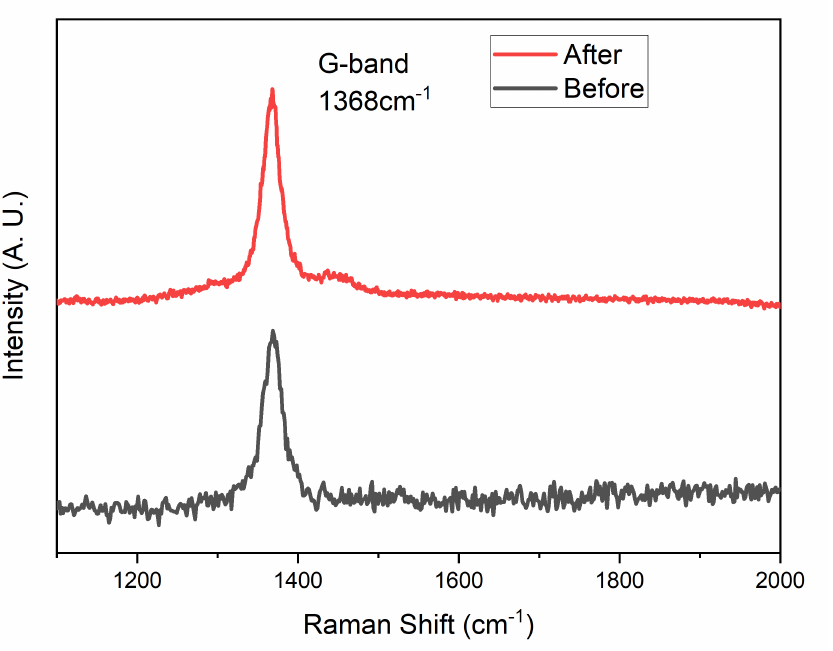
Figure 7. Raman spectroscopy of the BNNS before and after the AO